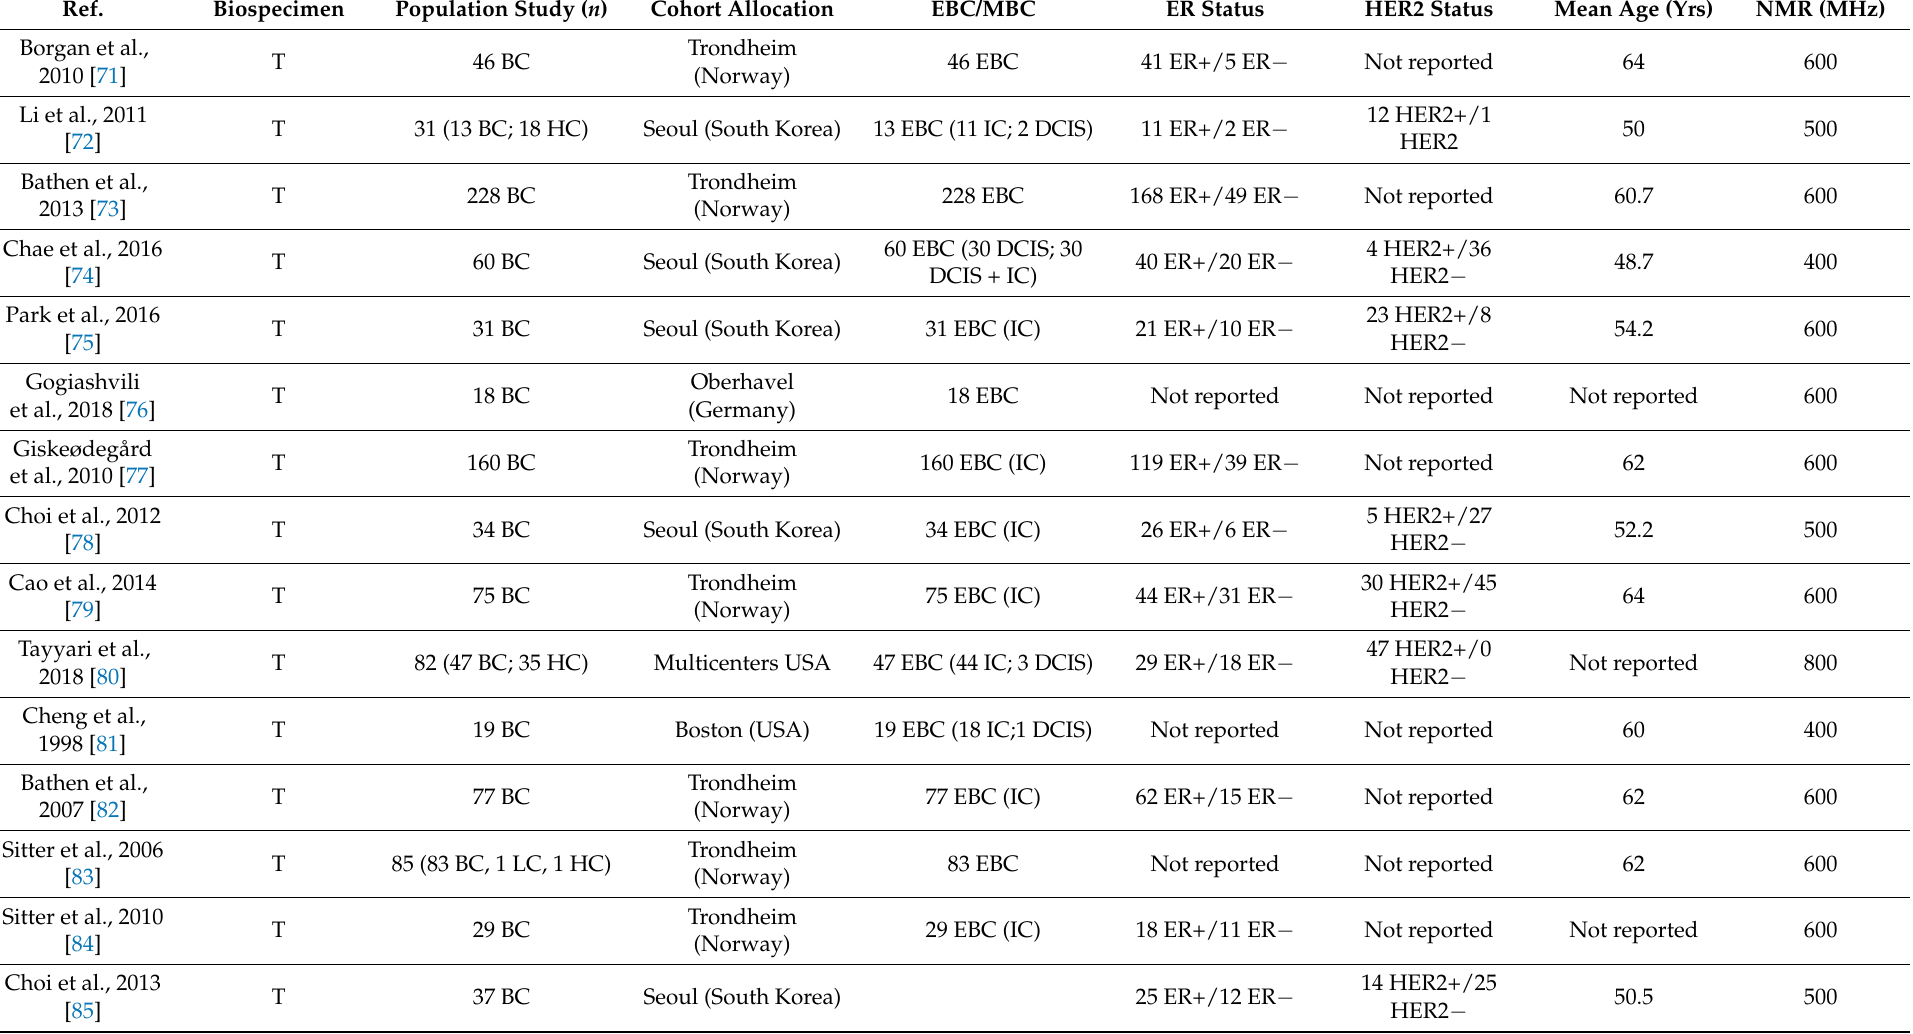
Table 1. List of evaluated